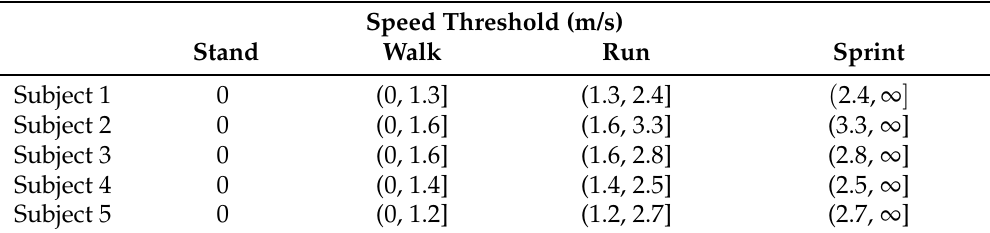
Table 1. Thresholds of Speeds Used for the Labelling of Each Subject’s Activities. Speed Threshold